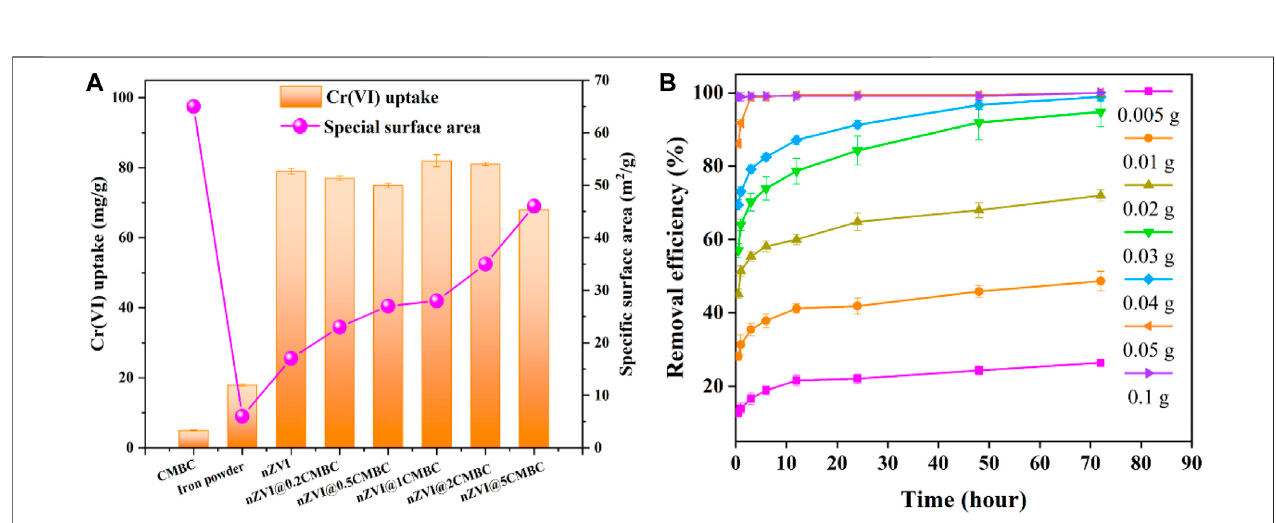
FIGURE 3 | Effects of mass ratios between nZVI and CMBC on Cr(VI) removal (A) ; effects of composite dosage on the Cr(VI) removal ef fi ciency (B) .